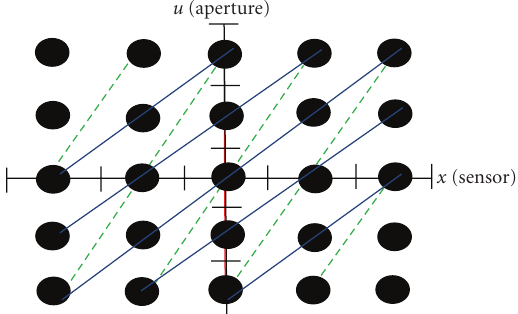
Figure 3: Photography transform for two particular α values.